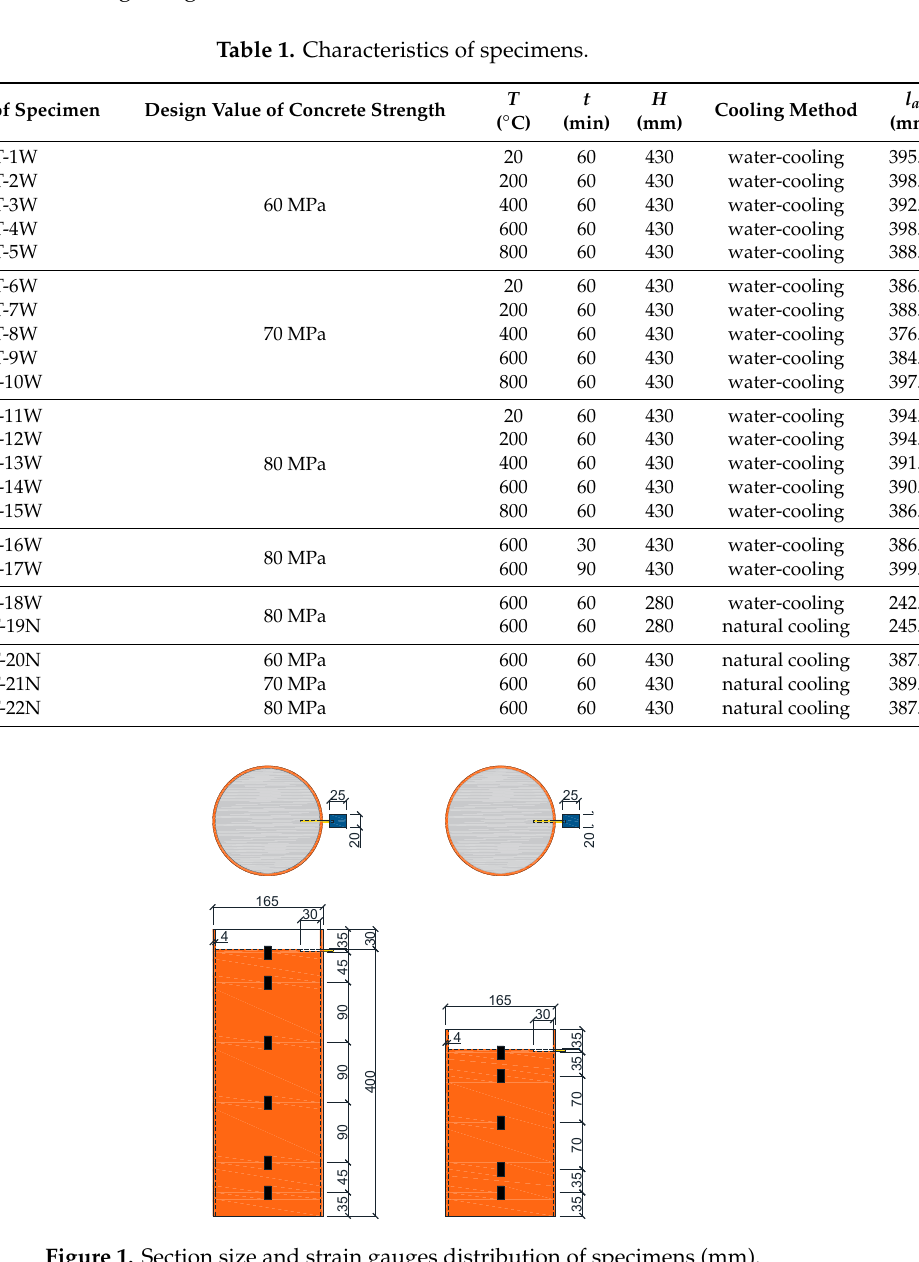
9 Table 3. The physical properties of coarse aggregate. Crushing Index (%)